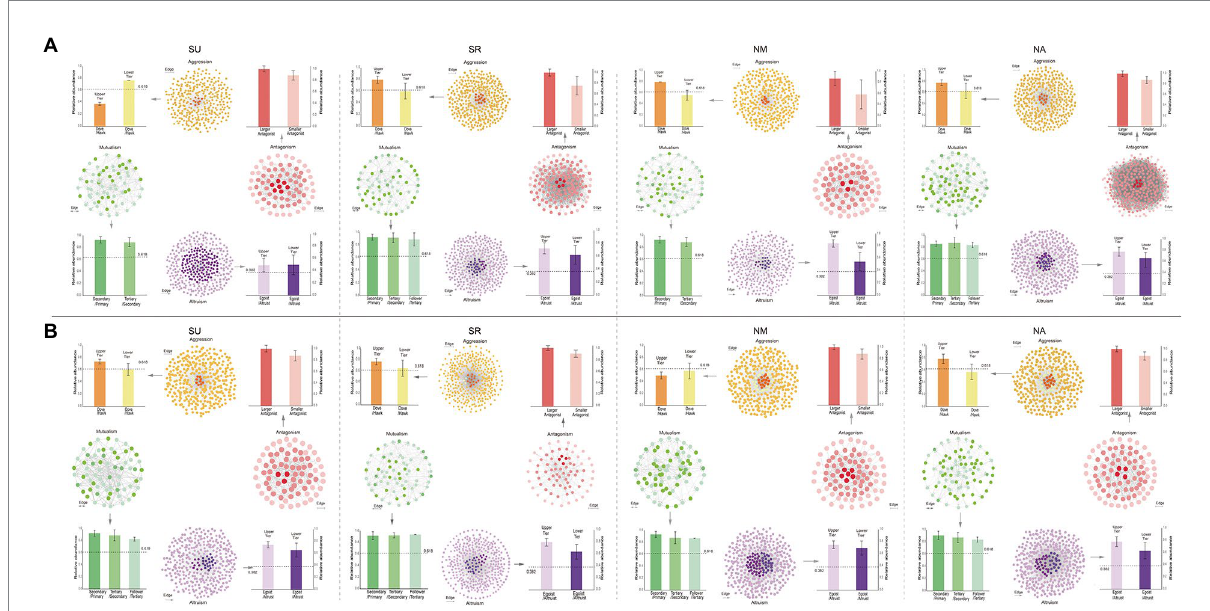
FIGURE 1 Social networks of microbiome in the leaf of Arabidopsis thaliana . (A) The results of four experiments in 2012, (B) The results of four experiments in 2013. In each plot, left: Mutualism network constructed by doubly-arrowed edges representing microbes cooperation; right: Antagonism network composed of doubly-T-shaped edges denoting the mutual conflict of the microbes; top: Aggression network represented by singly-T-shaped edges specifying how a microbe (as a hawk) aggresses upon others (doves; color metrics indicate three hierarchies of aggression); bottom: Altruism network characterized by singly-arrowed edges which illustrates how a microbe (altruist) benefits other microbes (egoists) at its own expense (color metrics indicate three hierarchies of